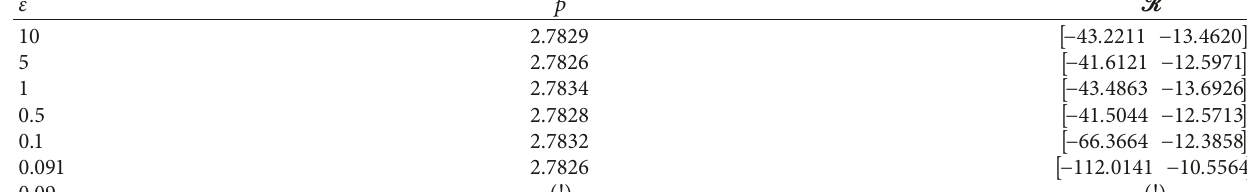
Table 1: Numerical results for different values of ε .